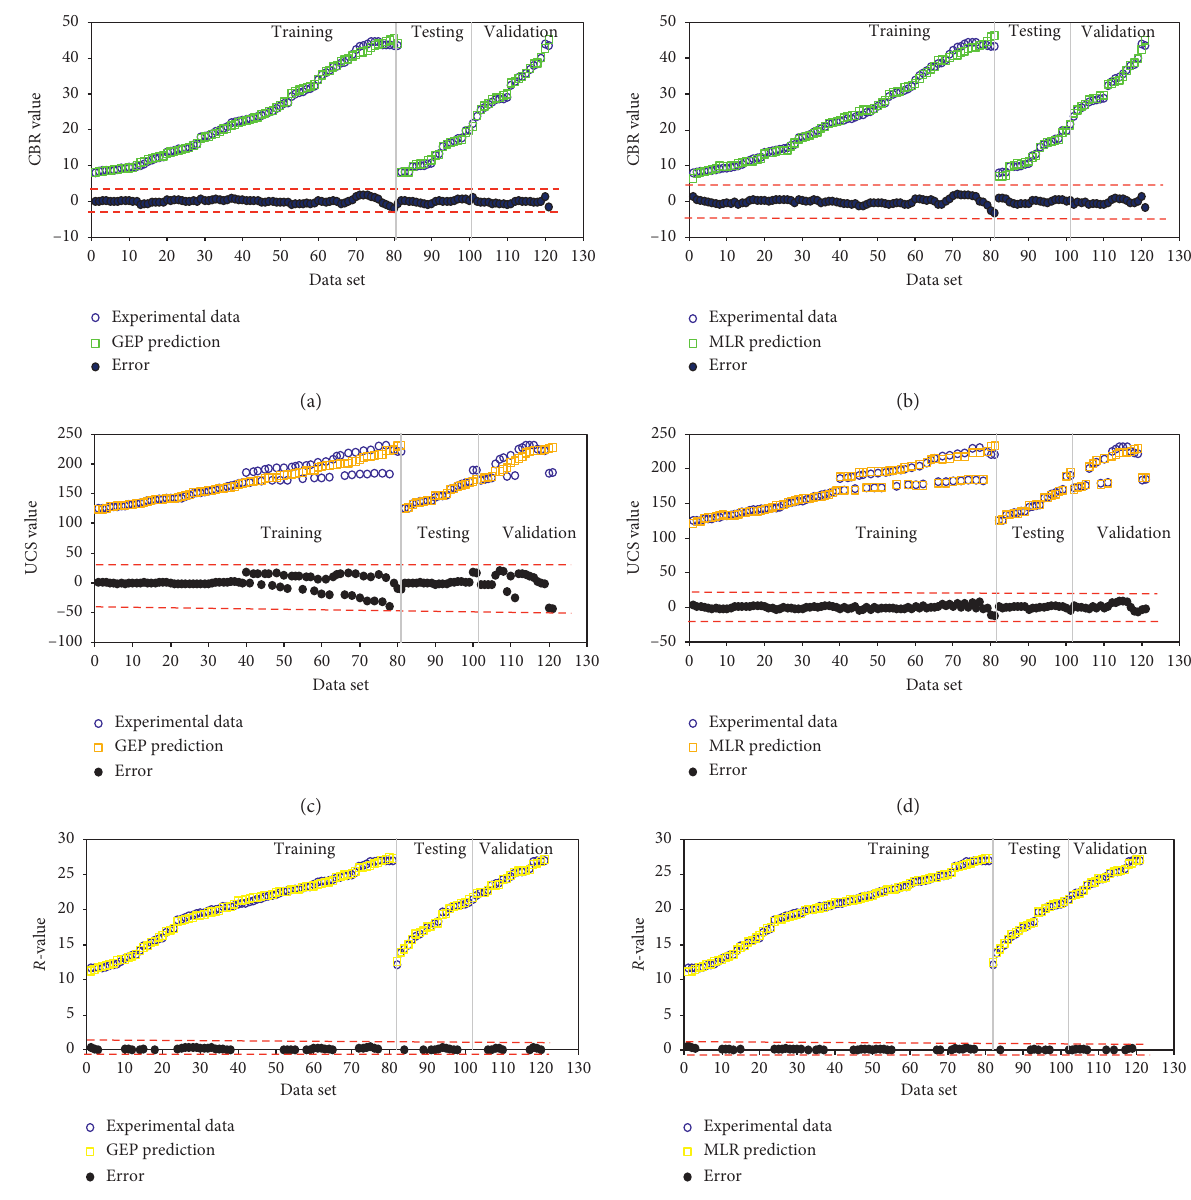
Figure 11: Error distribution diagram for CBR, UCS, and R value generated models using GEP and MLR, respectively. Table 5: Statistical calculations, performance indices, and objective functions of the GEP models for CBR, UCS, and R value. GEP